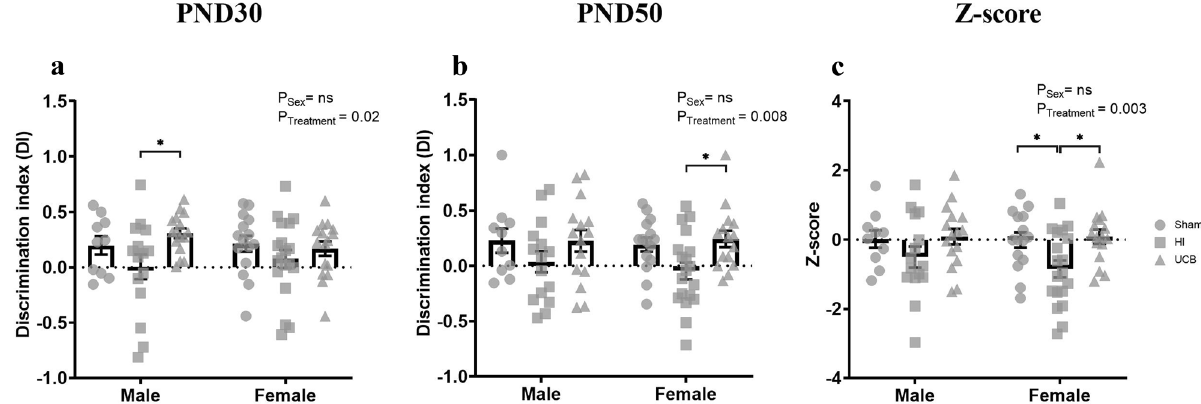
Figure 2. Raw and transformed scores for the novel object recognition test. Discrimination index (DI) was calculated for PND30 ( a ) and PND50 ( b ) where a positive DI shows preference toward the novel object and a negative score shows preference toward the familiar object. Raw scores were transformed into a novel object recognition Z-score ( c ). A positive Z-score reflects an improvement in behaviour, negative Z-score reflects deficit in behaviour. (In these graphs, the sham group is represented by a circle, the HI group is represented by a square and the UCB groups is represented by a triangle. Data expressed as mean ± SEM, n = 10–19 pups per group, *P <